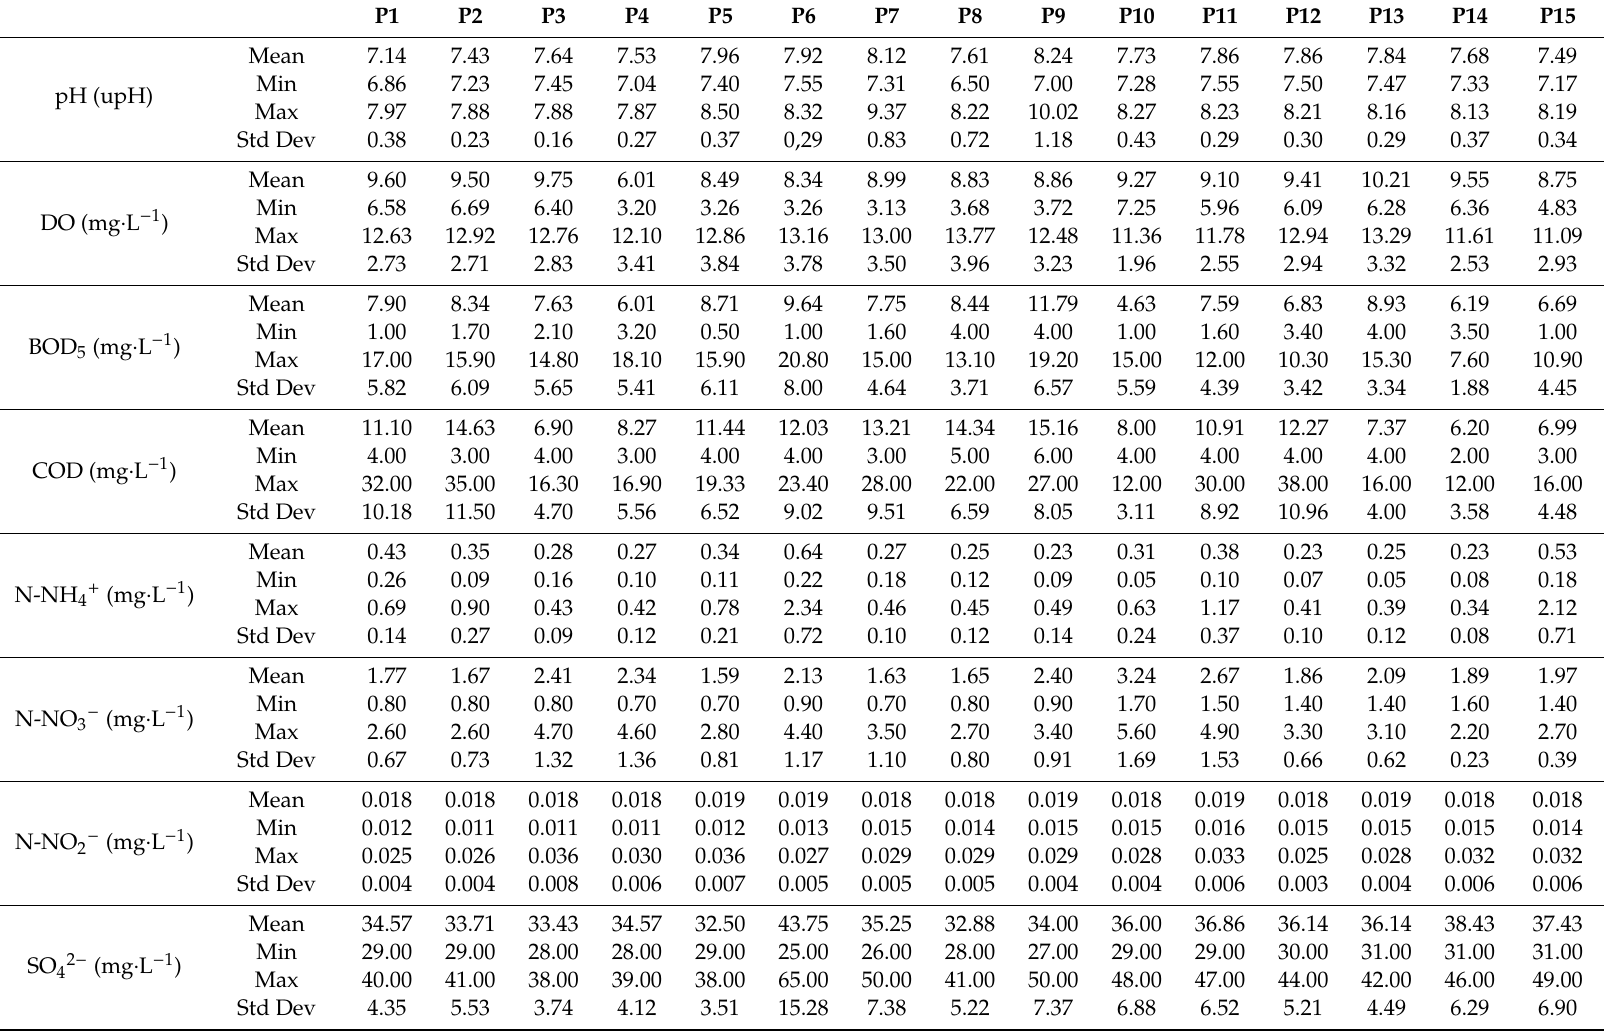
Table 6. Preliminary statistical analysis of the experimental